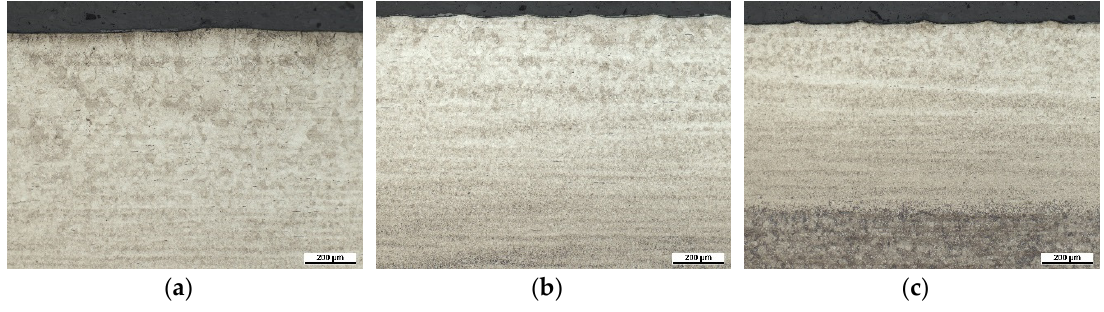
Figure 8. Microstructure of specimen after polishing and etching. The specimens were hardened with a top ‐ hat laser beam at a feed of 300 ( a ), 400 ( b ) and 500 mm/min ( c ). The tracks achieved with the optimized heat distribution can be seen in Figure 9. At 300 mm/min